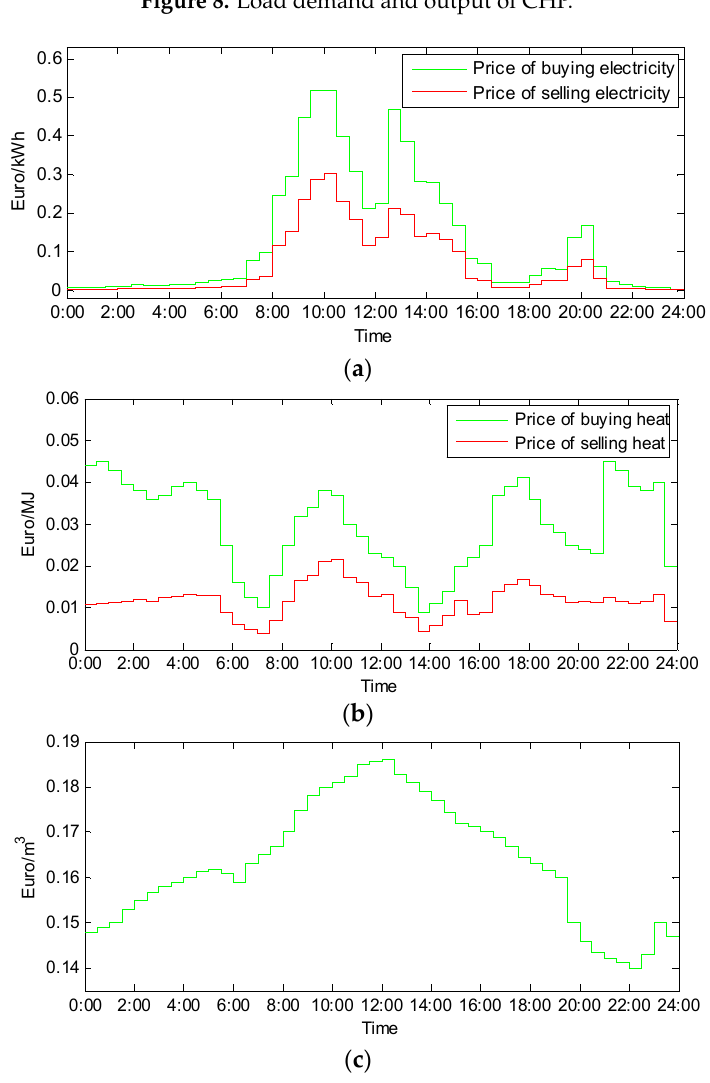
Figure 9. Energy prices in the real ‐ time market: ( a ) price of buying and selling electricity; ( b ) price of buying and selling heat; and ( c ) price of natural gas.